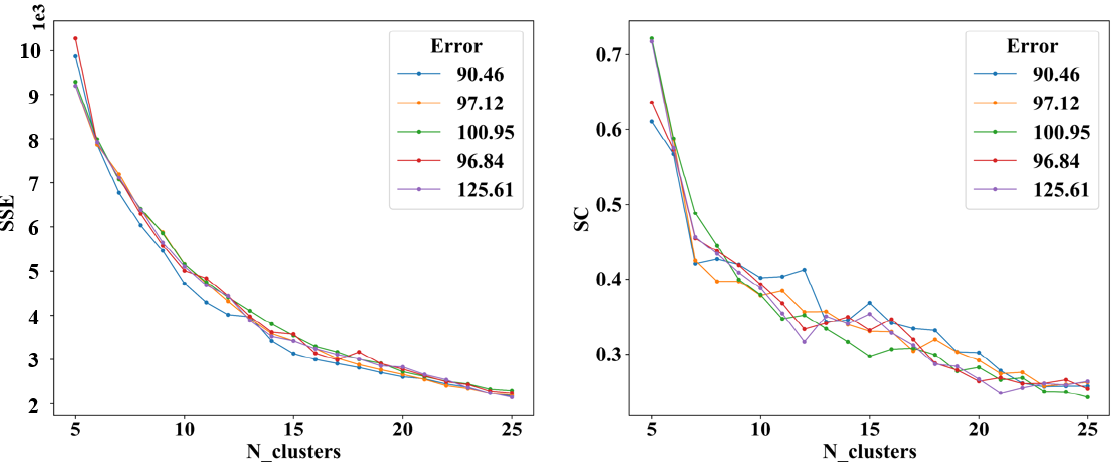
Figure 4. Clustering effect of arrival trajectories under different reconstruction errors.